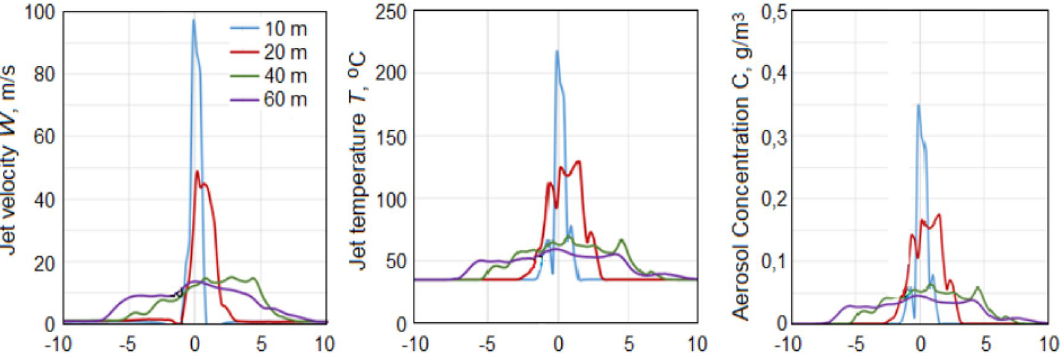
Figure 7. Instantaneous patterns of radial distributions of the updraft speed W (m/s), temperature T (°C) and aerosol concentration C (g/m 3 ) at altitudes of 10, 20, 40 and 60 m in a windless atmosphere at γ = 6.5 °C/km and f = 45% 20 s after the launch of the turbojet device shown in Fig. 5.